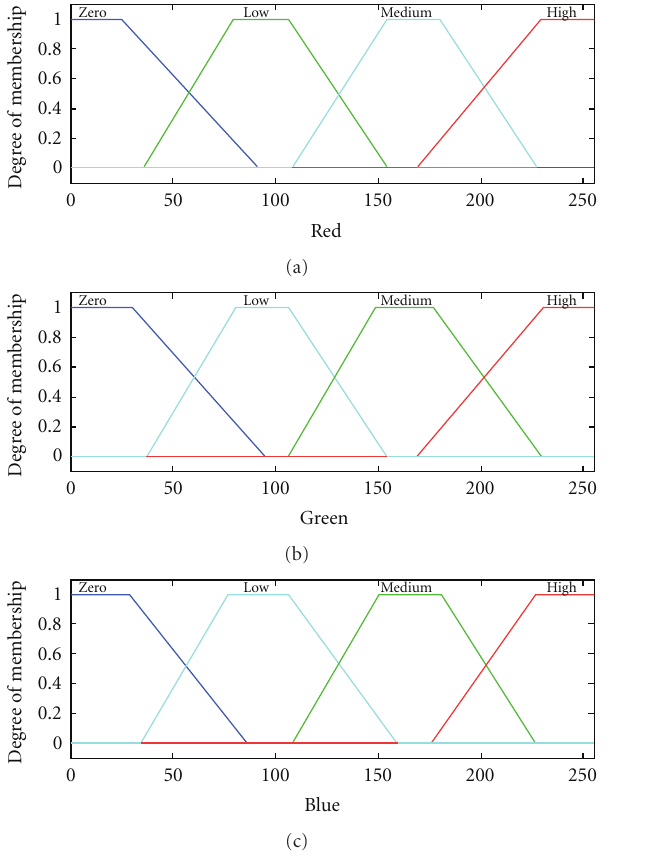
Figure 6: Membership functions of fuzzy analyzer inputs (red, green, and blue).